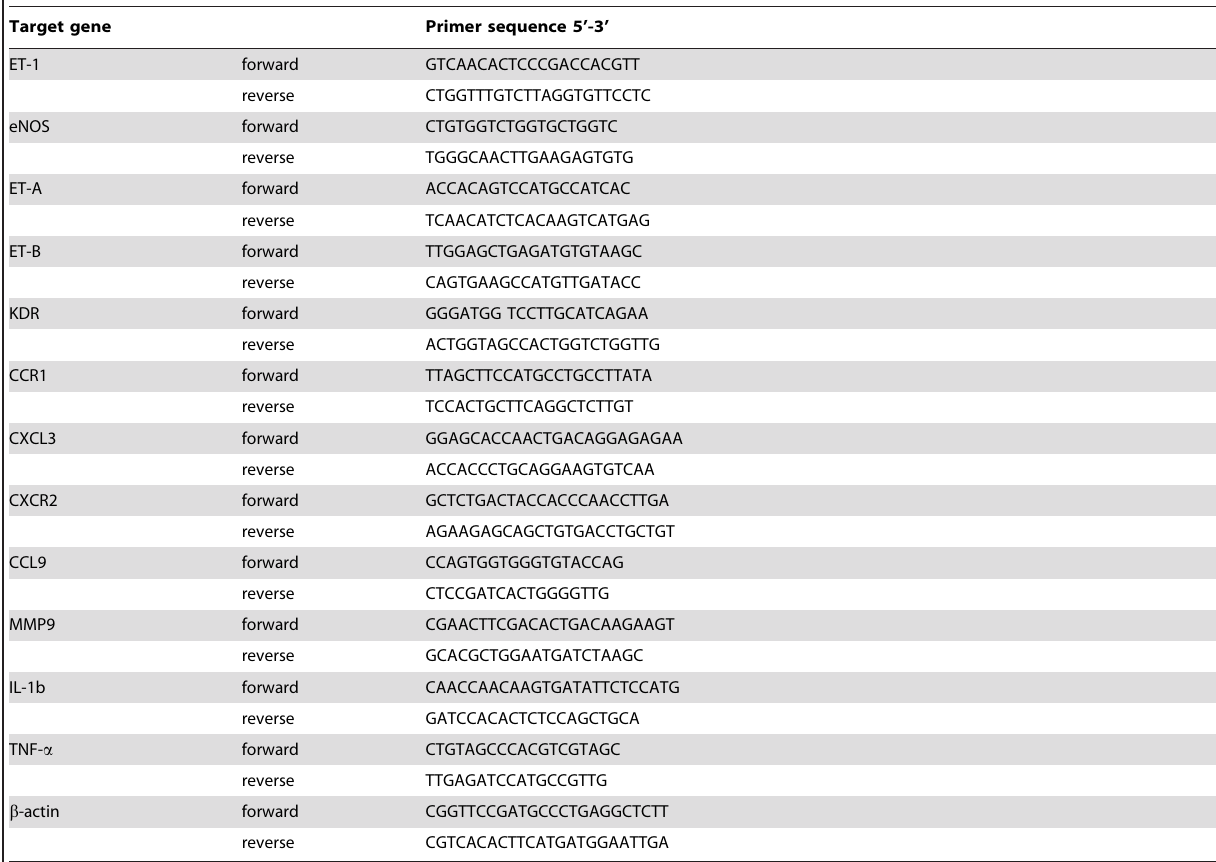
Table 1. Primer sequences for quantitative